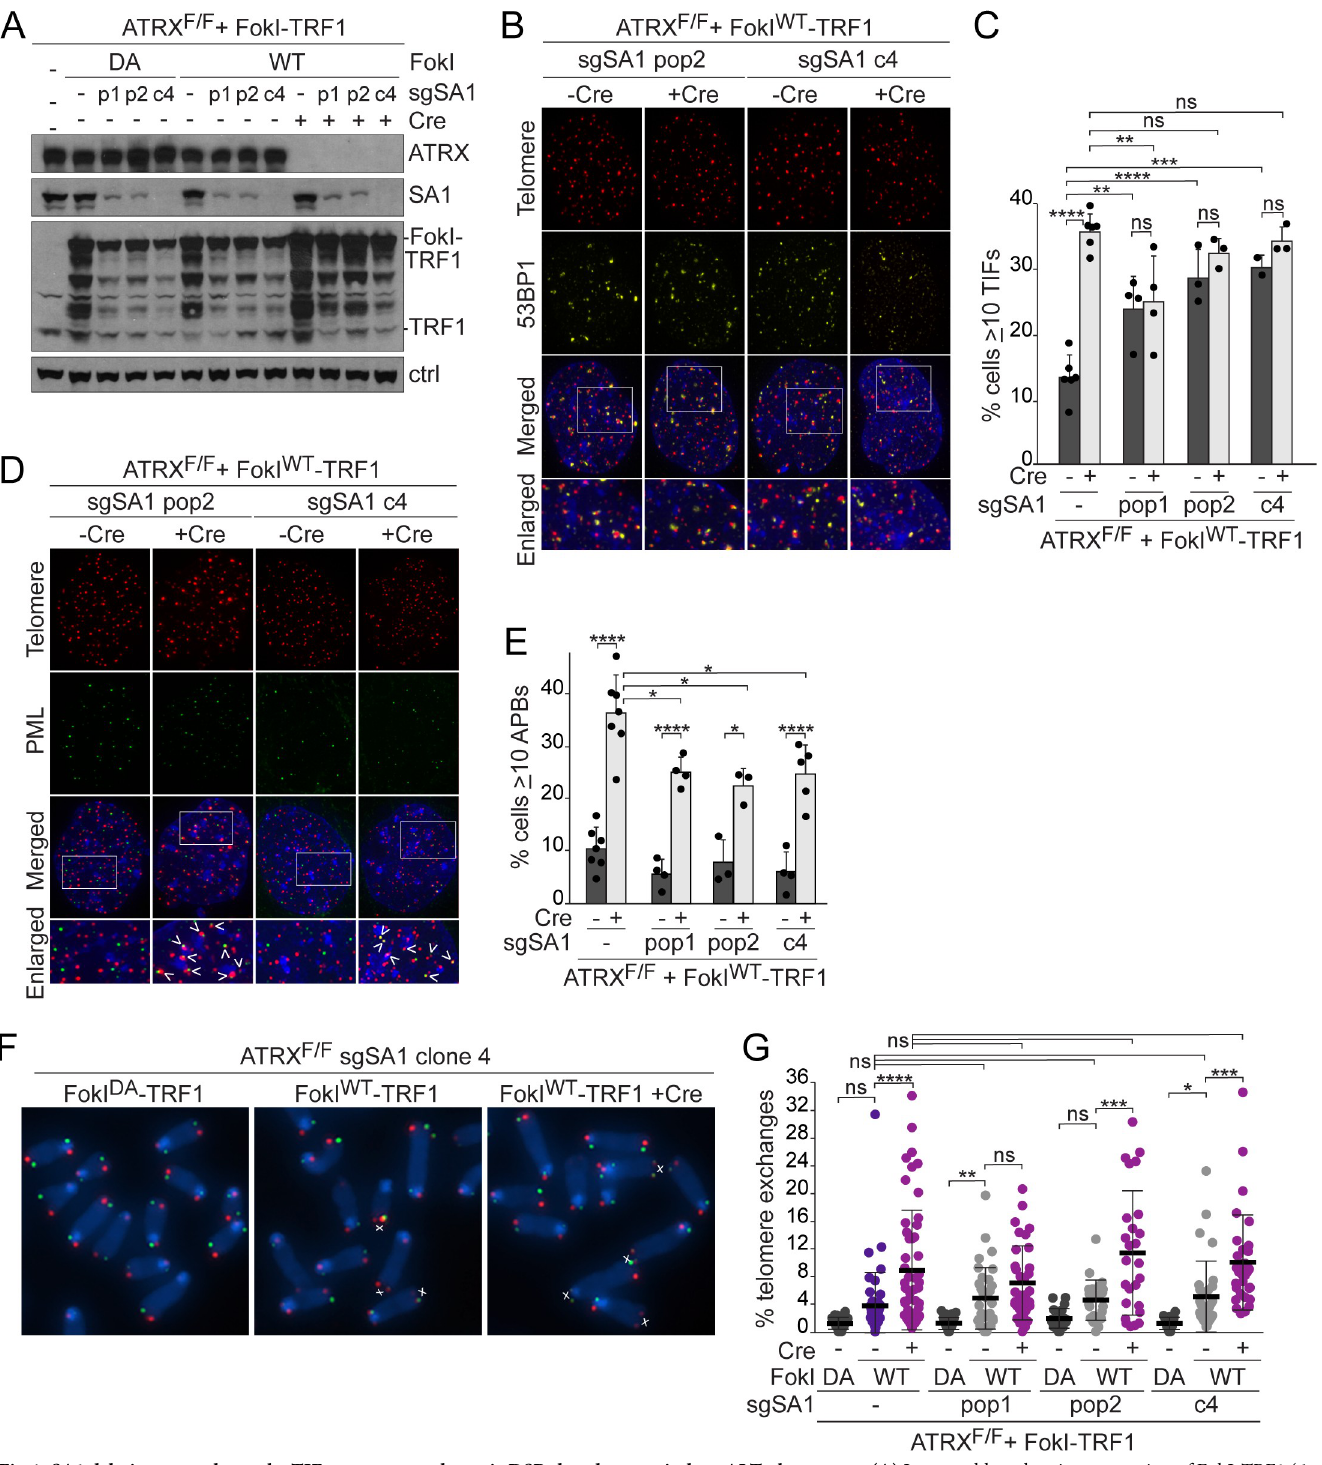
Fig 4. SA1 deletion exacerbates the TIF response to telomeric DSBs but does not induce ALT phenotypes. (A) Immunoblots showing expression of FokI-TRF1 (6 days) in control and CRISPR/Cas9-targeted SA1 KO ATRX F/F MEFs infected with Cre (4 days). p1/p2, two separate SA1-targeted populations of cells; c4, SA1 KO clone; Ctrl, nonspecific band used as a loading control. (B) TIFs in SA1 KO ATRX F/F MEFs expressing FokI WT -TRF1 detected by IF-FISH as in Fig 1C. (C) Quantification of the TIF response in FokI WT -TRF1–expressing cells, as assayed in (B). Bars: means and SDs from at least 3 experiments of > 100 cells each. (D) APBs in SA1 KO ATRX F/F MEFs expressing FokI WT -TRF1 detected by IF-FISH as in Fig 1E. (E) Quantification of the percentage of cells with � 10 APBs in MEFs expressing